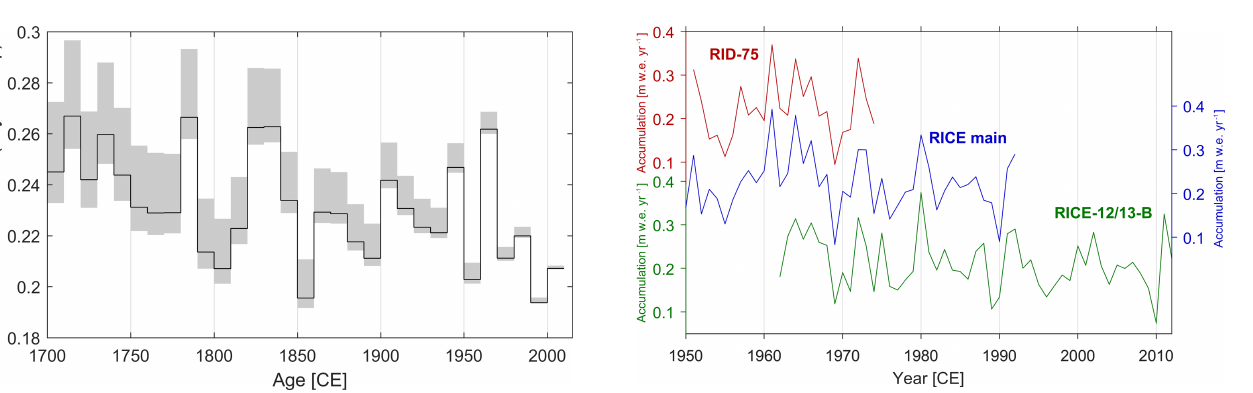
Figure 12. Decadal accumulation rates at Roosevelt Island since 1700CE. Grey shadows indicate the 95% uncertainty bounds on the accumulation rate reconstruction due to uncertainties in the thinning function.